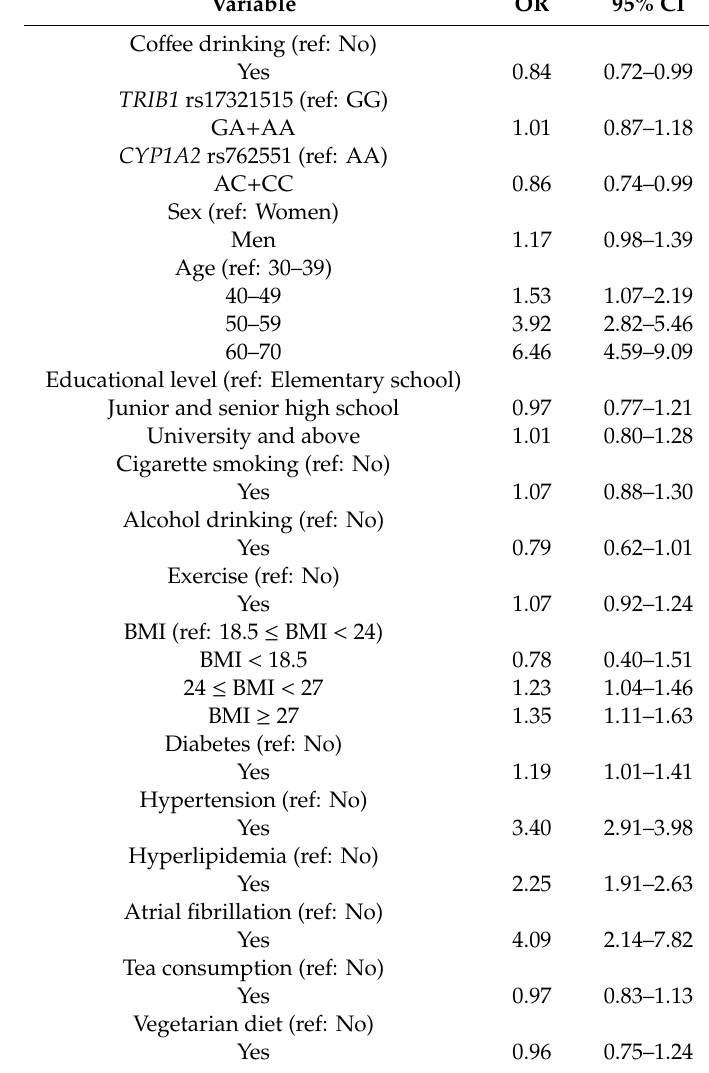
Table 3. Association of CHD with associated